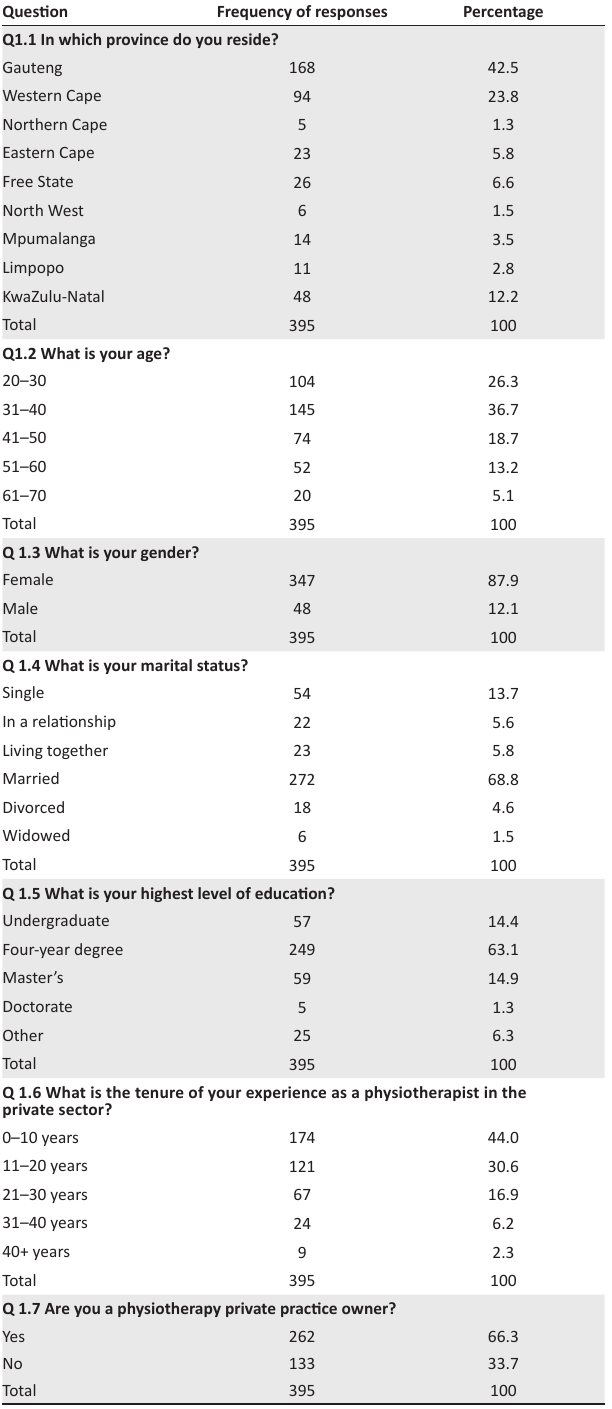
TABLE 2: Demographic frequency distribution ( n = 395).